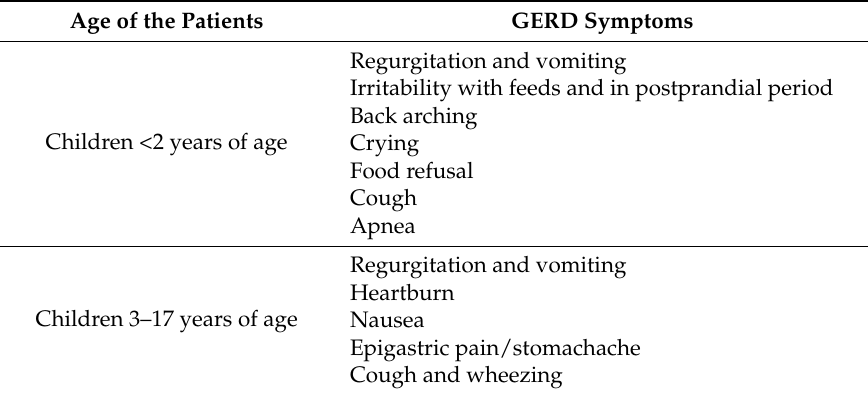
Table 1. Gastro-esophageal reflux disease (GERD)—Age related symptoms